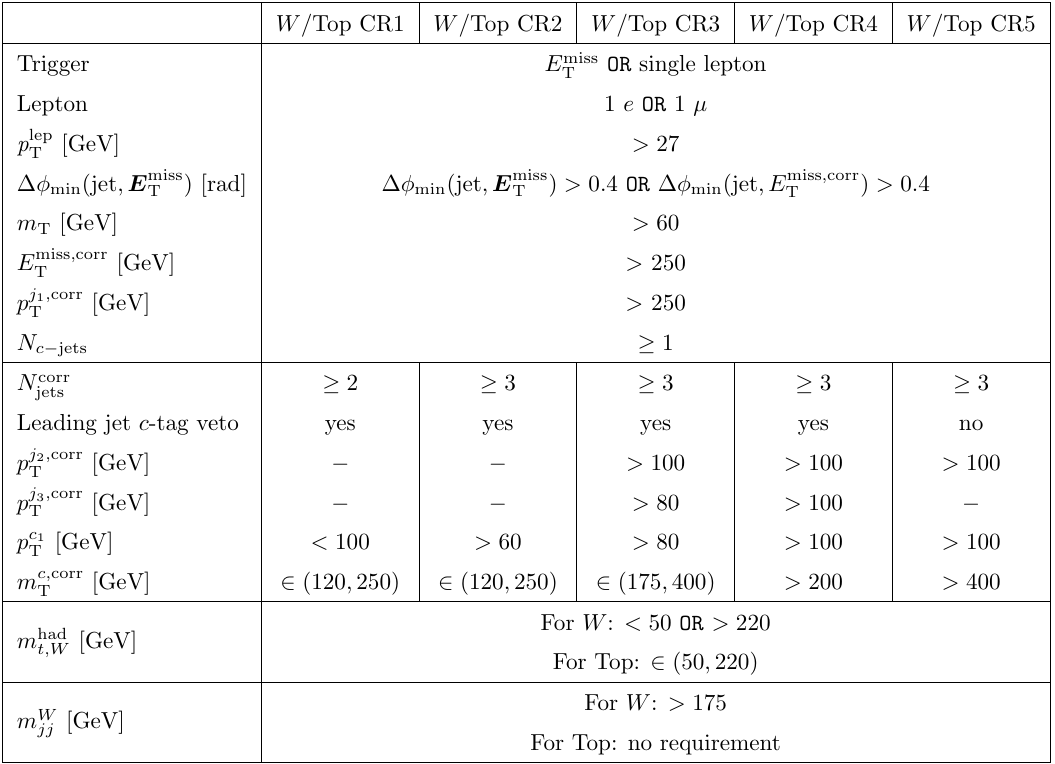
, p j 2 and p j 3 indicate the transverse momentum T T T is the transverse momentum of the T is the lepton p T . Variables with the superscript \corr" refer to T